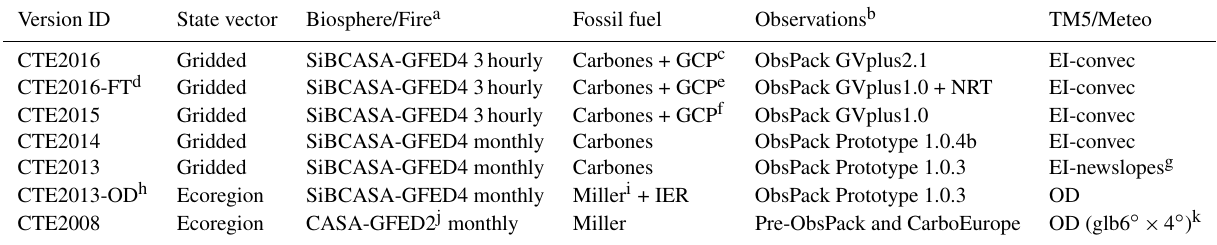
Table 2. Version information for CarbonTracker Europe simulations, with details on used setup including prior fluxes, observations, meteo- rological data and TM5 setup. References are provided in Sect. 3.1 and in the footnotes.